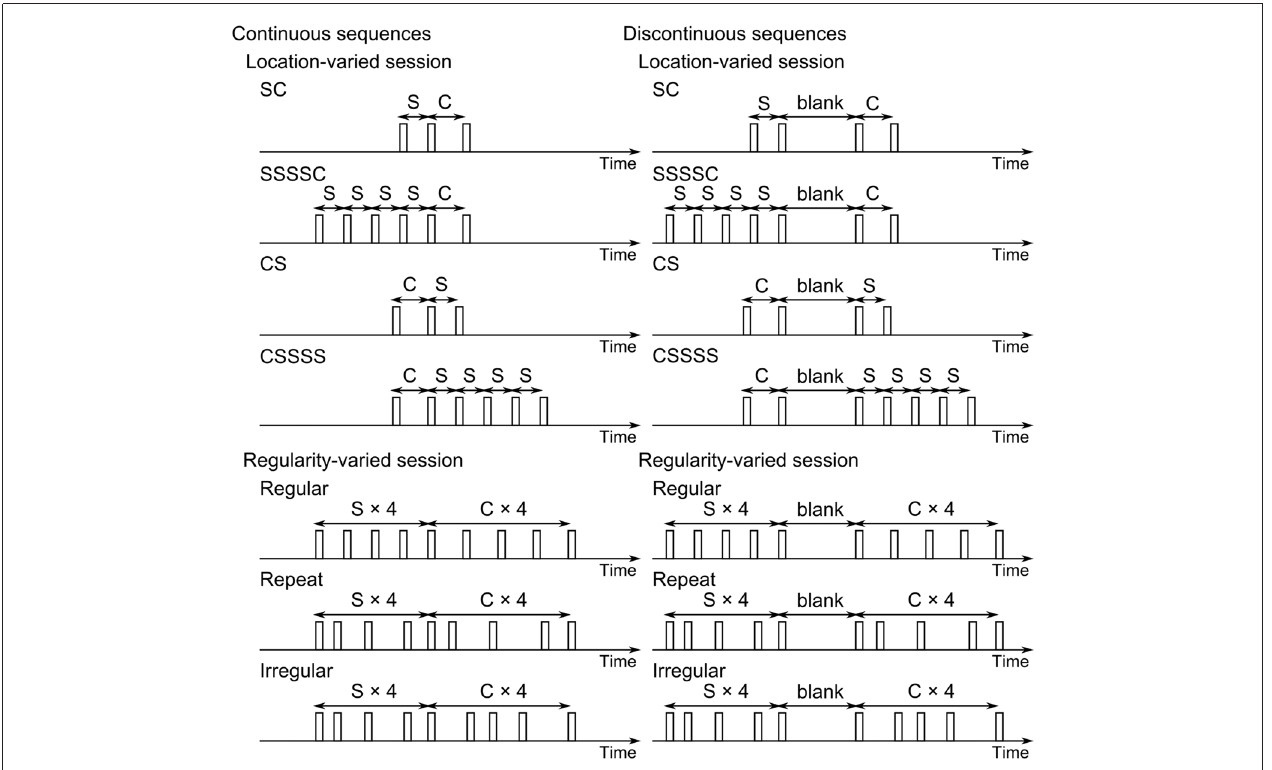
FIGURE 1 | Stimuli used in the present study. The standard duration (S) was 200, 300 or 400 ms. The comparison duration (C) was 60 ms (140 ms in training) briefer or longer than S. The blank duration was 3.0 to 3.5 times of